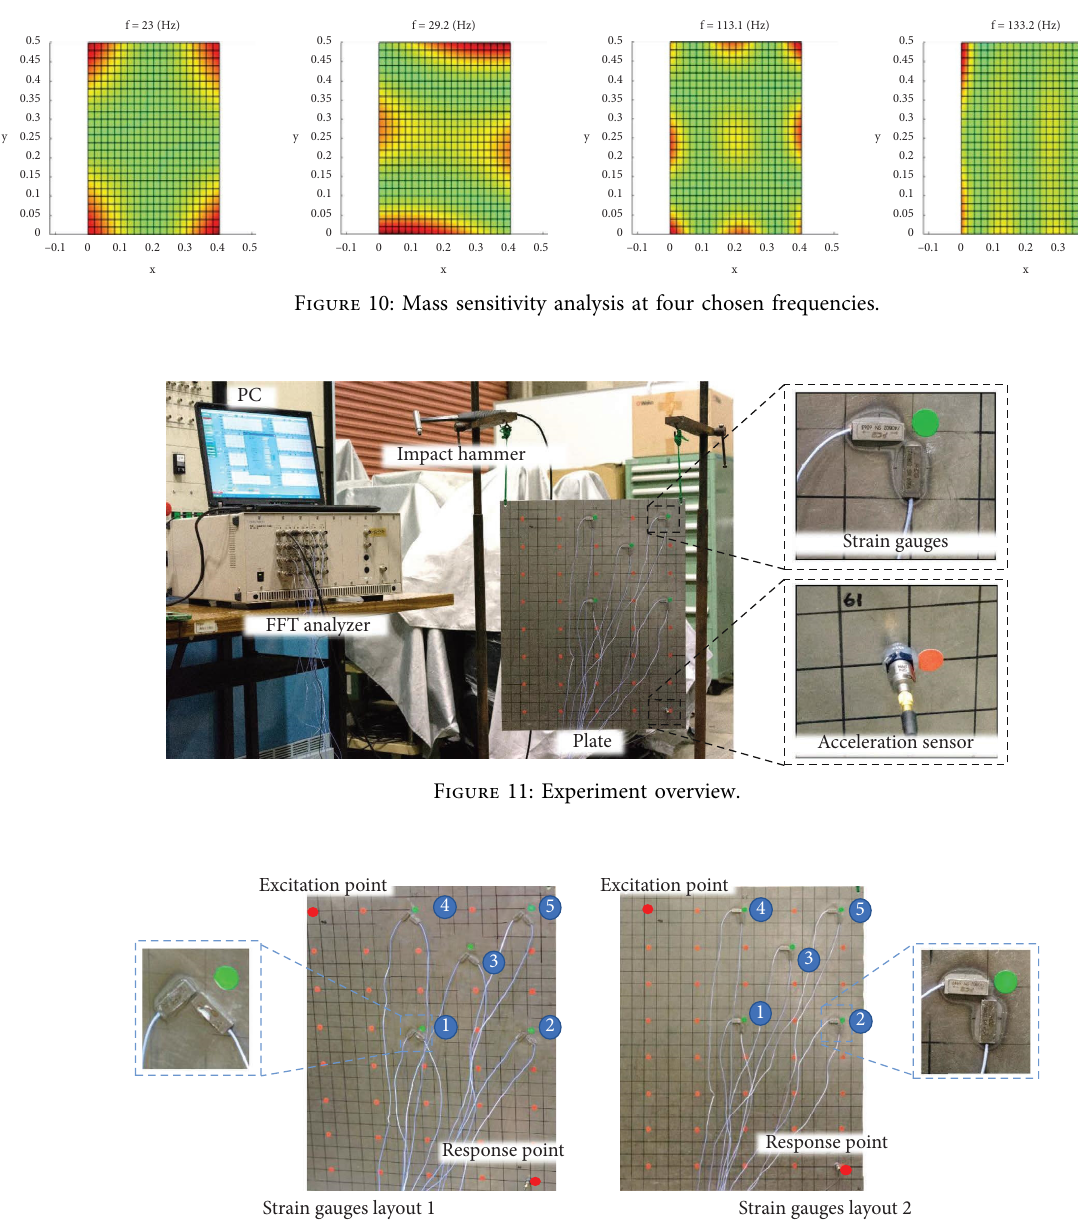
Figure 12: Two strain sensors’